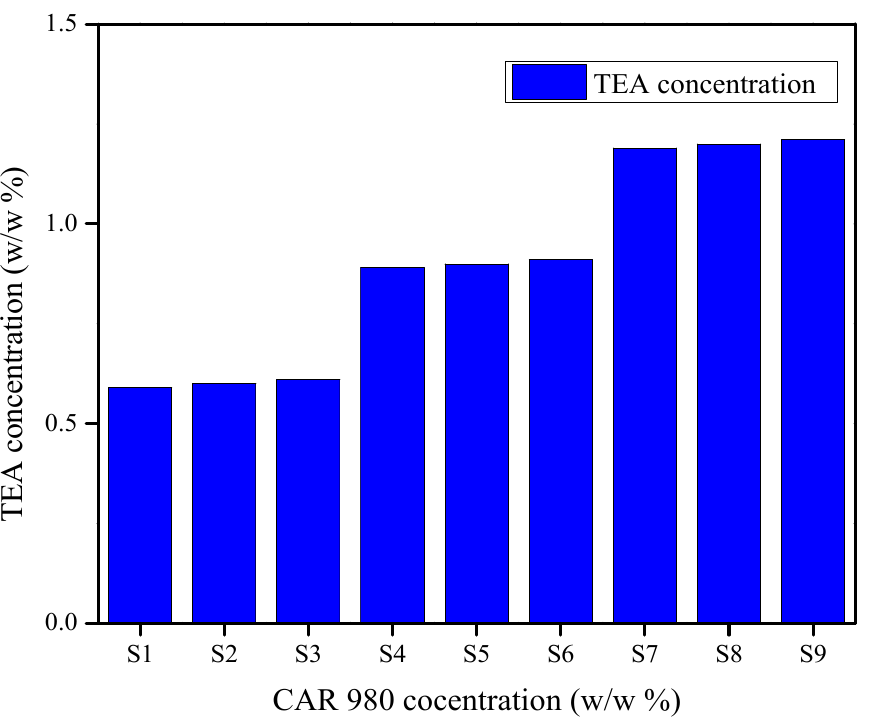
Figure 5. An increase in the concentration of triethanolamine was observed with an increase in the polymer (CAR 980) concentration to attain the pH of all formulations between 7 and 7.4.